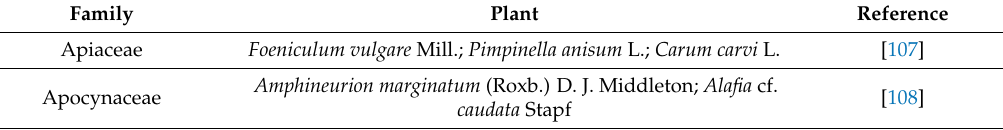
Table 1. Medicinal species containing PA